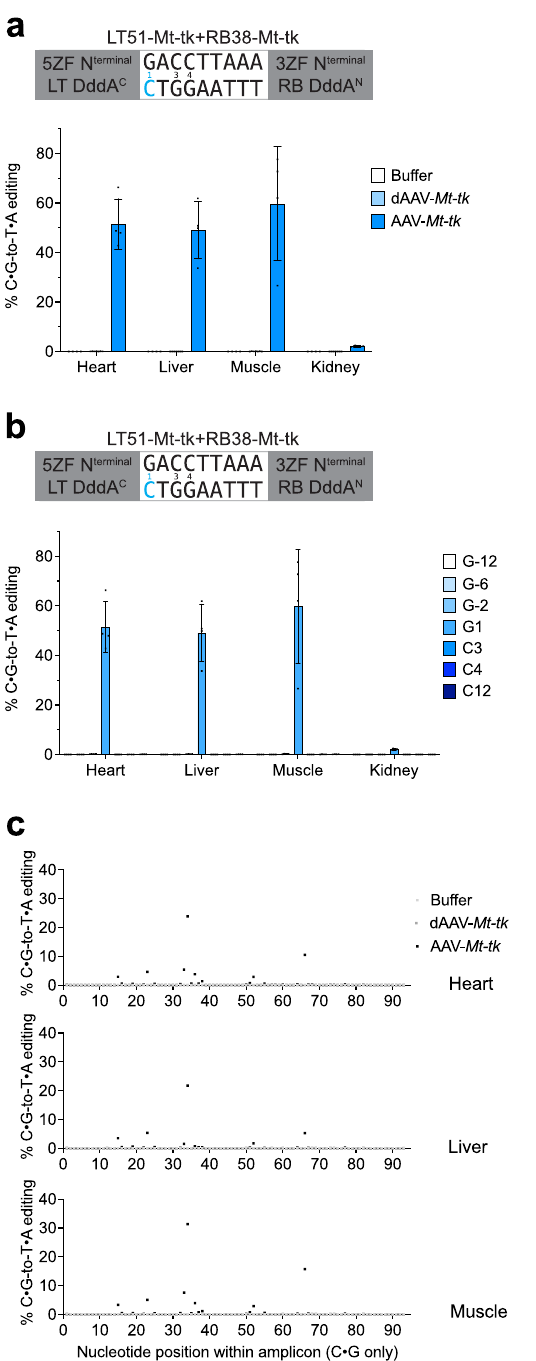
nucleotide mismatches and four off-target sites for the right 5ZF array